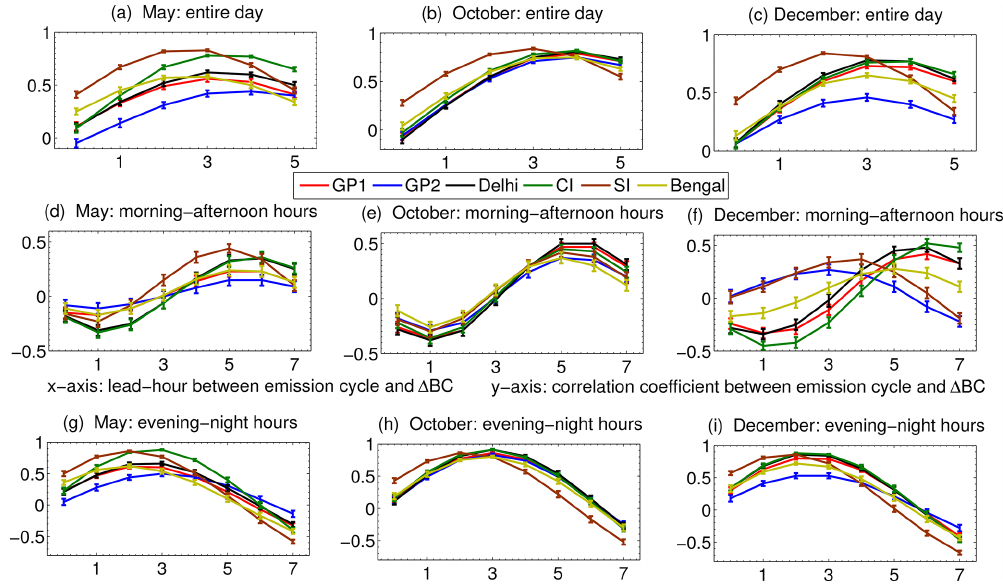
Figure 6. Correlation coefficients between hourly values of the emission cycle (i.e., the diurnality factor) and (cid:49) BC, at different lead hours – considering all times of the day (00:00–24:00IST) in (a) May, (b) October and (c) December; considering only the morning–afternoon hours (07:30–17:30IST) in (d) May (e) October and (f) December; and considering only the evening–night hours (18:30–06:30IST) in (d) May, (e) October and (f) December. For (a) – (c) , (d) – (f) and (g) – (i) , all the coefficient values with magnitudes greater than 0.15, 0.2 and 0.22, respectively, are significant, with p < 0 . 0001. The meanings of the abbreviations are as follows: GP1 – Gangetic Plain 1; GP2 – Gangetic Plain 2. The other abbreviations are defined in Fig.